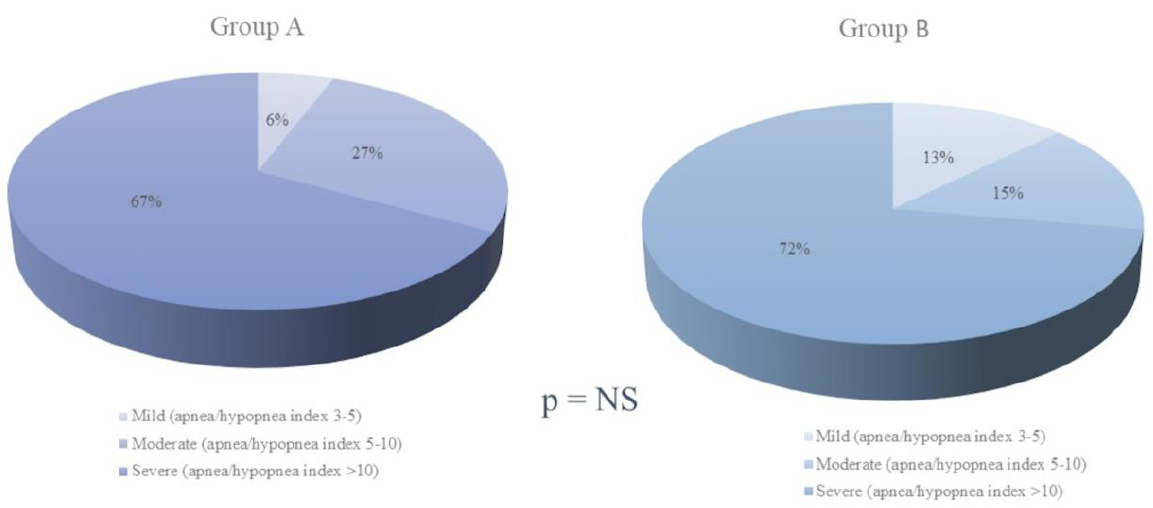
Figure 2. Comparison of obstructive sleep apnea severity measured by the apnea–hypopnea index (AHI) in Groups A and